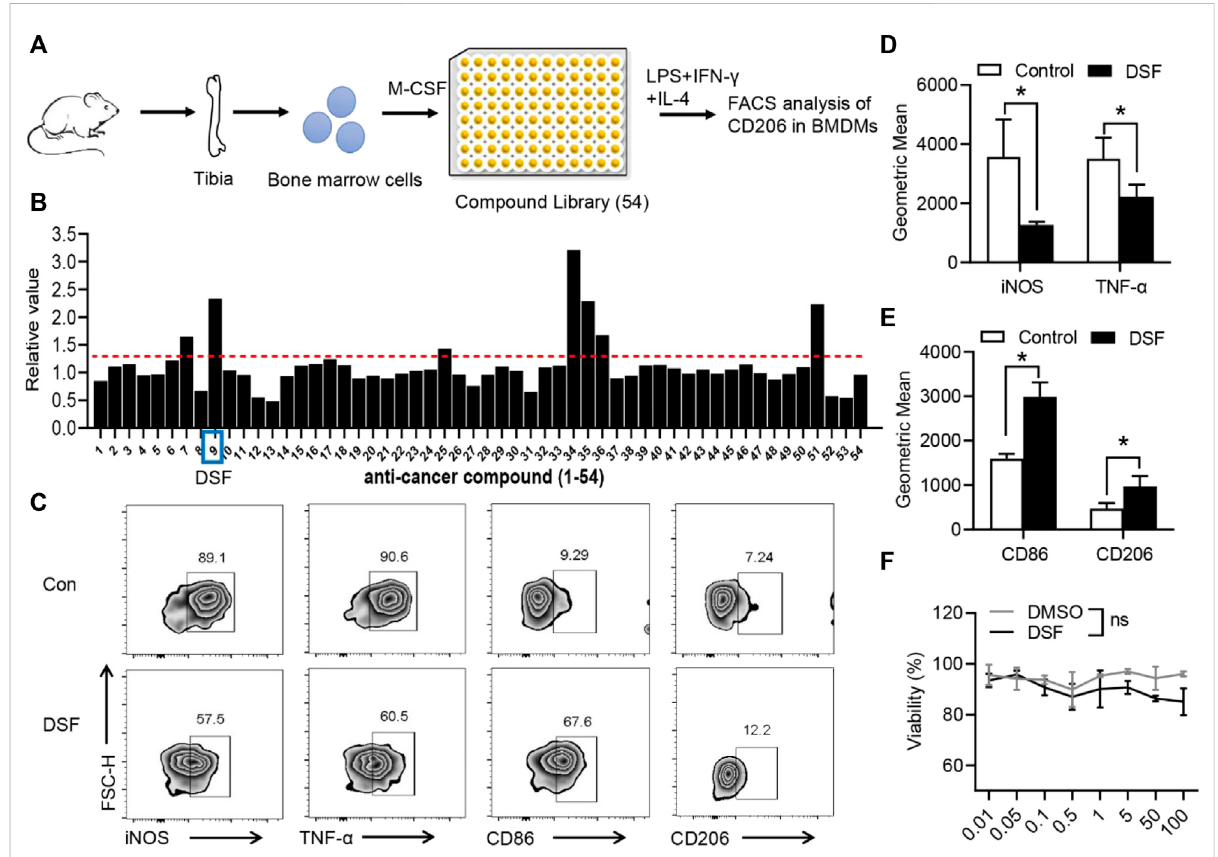
FIGURE 2 DSF signi fi cantly promotes pro-in fl ammatory macrophages into the M2-type phenotype. (A) The diagram of screening assay. Bone marrow cells were isolated from the tibia of wild-type mice. BMDMs were induced by M-CSF (50 ng/ml). Then the cells were treated with LPS (100 ng/ml), IFN- γ (20 ng/ml), and IL-4 (20 ng/ml) for 6 h and underwent FACS analysis of CD206 expression. (B) Quantitative analysis of the candidates in screening assay. (C) BMDMs werepretreated with DSF(5 μ M) orDMSO(0.01%).Then thecellsweretreated with LPS(100 ng/ml),IFN- γ (20 ng/ ml), and IL-4 (20 ng/ml) for 6 h. FACS analysis of iNOS, TNF- α , CD86, and CD206. (D,E) Quantitative analysis of geometric mean of iNOS (D) , TNF- α (D) ,CD86 (E) ,andCD206 (E) . (F) CCK-8analysisofBMDMsaftertreatmentwithDSFatdifferentdosages.Dataarepresentedasthemean±SEM( n = 3) (D-F) . * p <